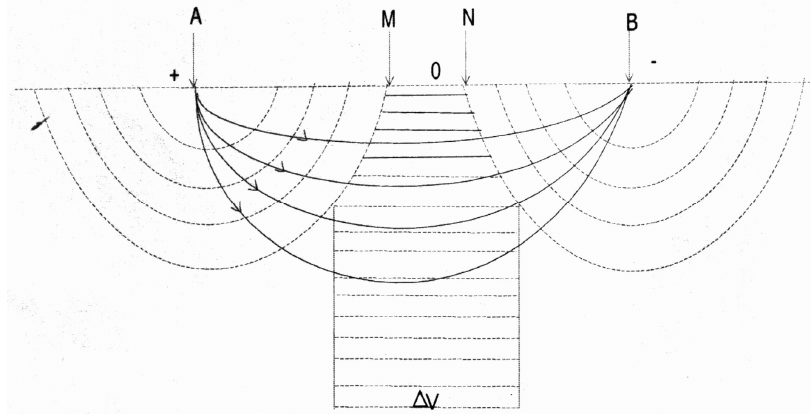
Figure 1. Schlumberger array with current (bold) and equipotential (dotted)